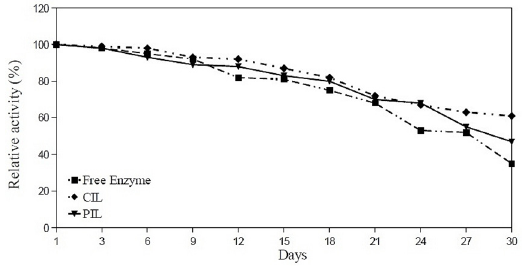
Figure 7: Storage stability of free and immobilized